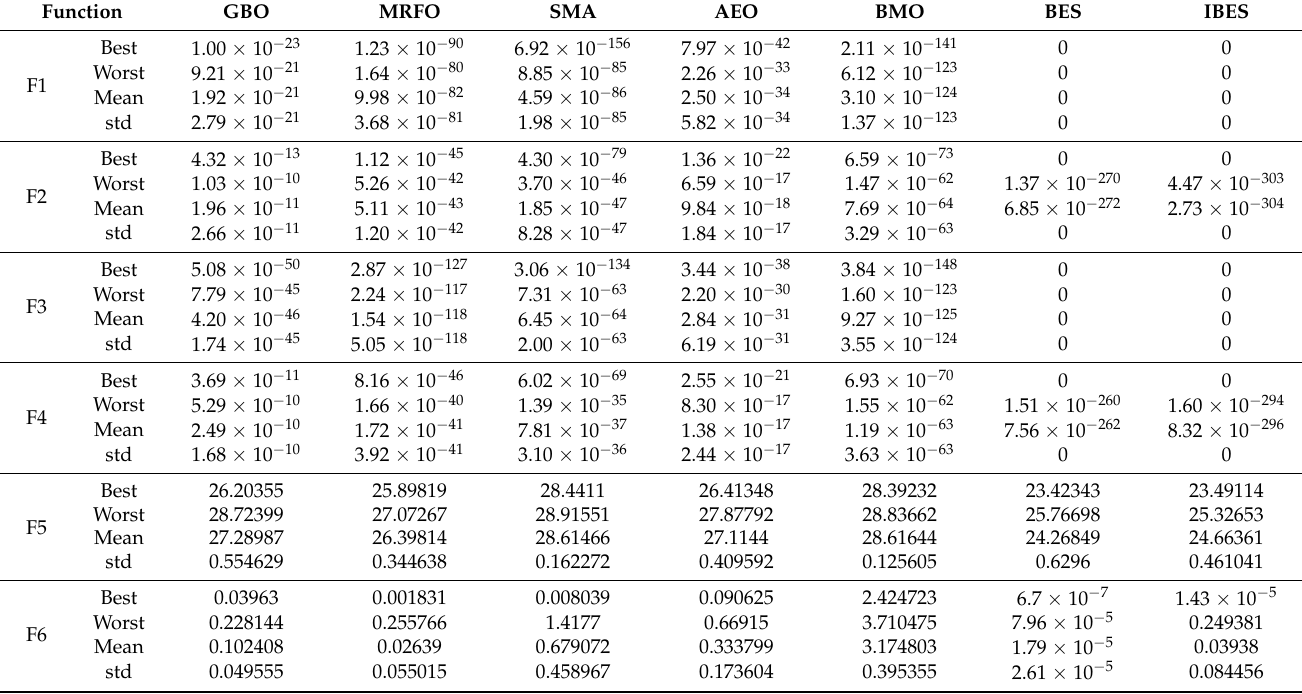
Table 2. Results for unimodal benchmark